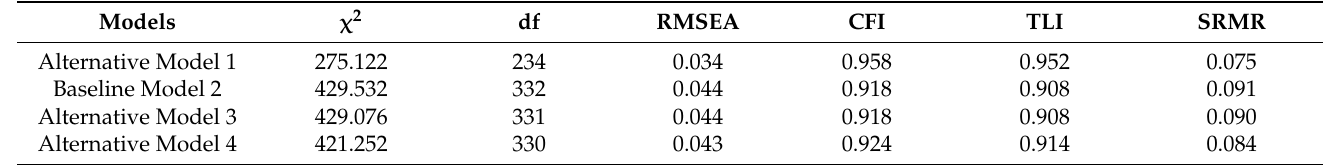
Table 4. Competitive structure model fitting